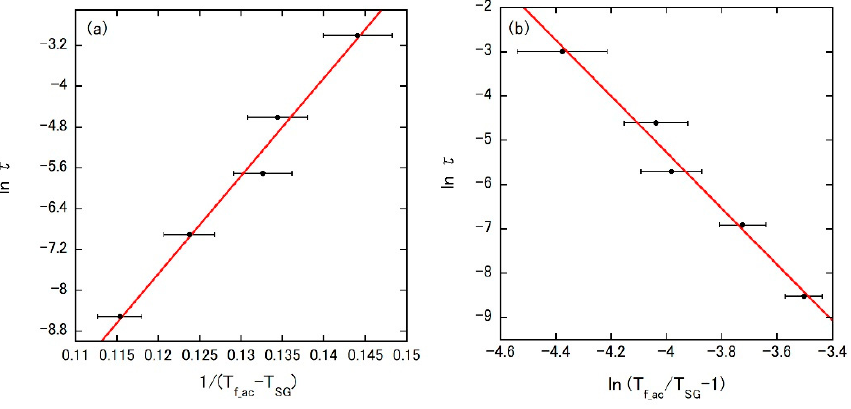
Figure 7. Fitting results of T f_ac shift in χ ac’ ( T ) using ( a ) Vogel–Fulcher law and ( b ) critical scaling approach for FeRhIrPdPt, respectively. Table 3. Fitting parameters obtained by Vogel–Fulcher law and critical scaling approach for FeRhIrPdPt.